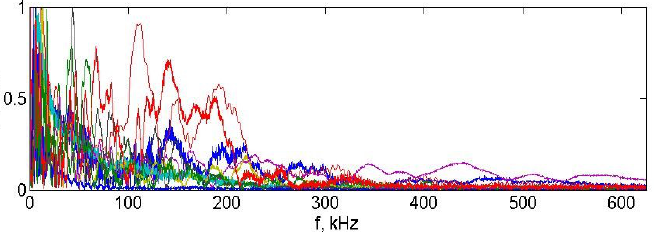
Figure 14. Signals spectrum for 10 different acoustic signals (different colors refer to different signals) recorded by the proposed circuit map of the R max